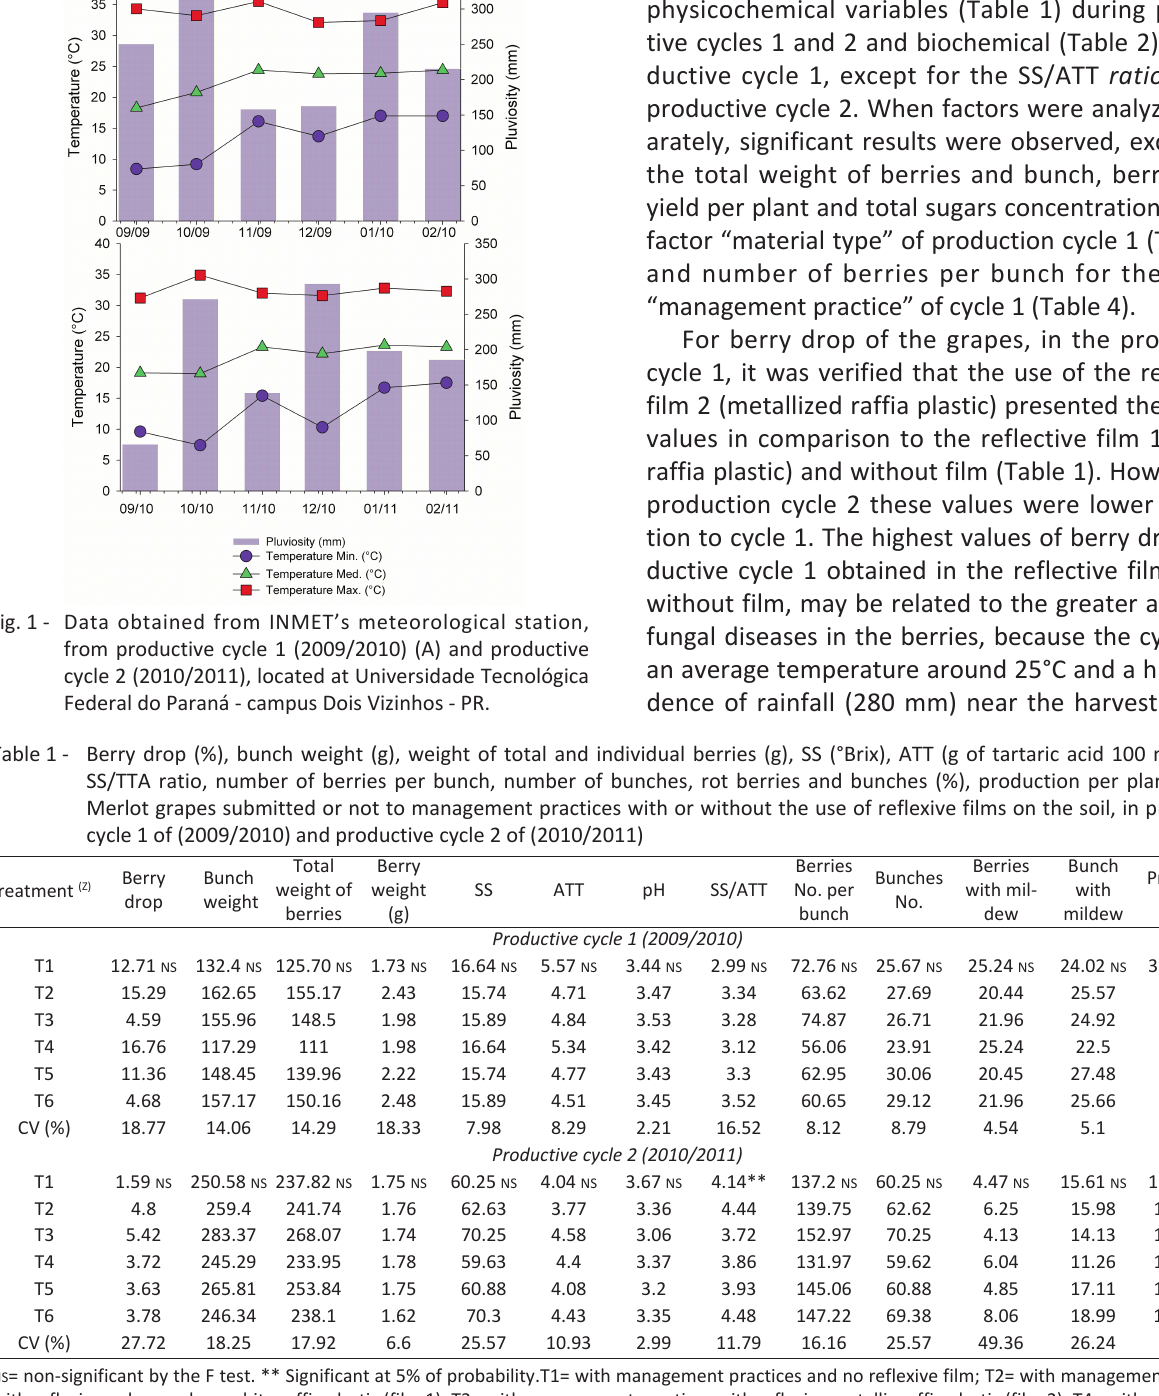
NS = non-significant by the F test. ** Significant at 5% of probability.T1= with management practices and no reflexive film; T2= with management practices with reflexive polypropylene white raffia plastic (film 1); T3= with management practices with reflexive metallic raffia plastic (film 2); T4= without manage- ment practices and no reflexive film; T5= without management practices with reflexive polypropylene white raffia plastic (film 1) and (T6) without mana- gement practices with reflexive f metallic raffia plastic